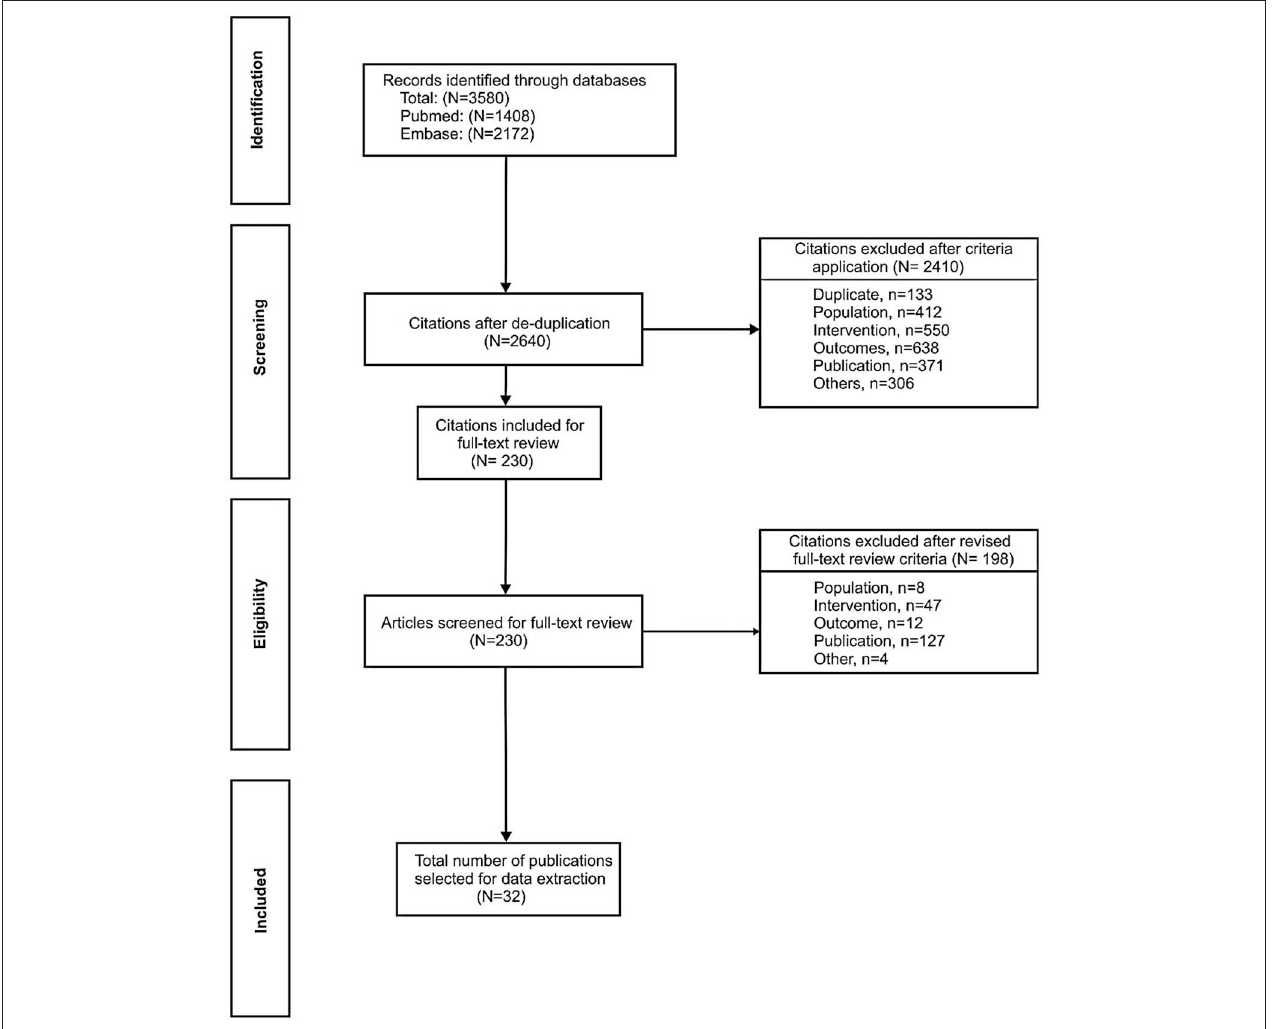
FIGURE 1 | PRISMA flow diagram of included studies. To supplement the 32 publications identified through the systematic process, data from three additional publications were also reviewed as they were considered to provide relevant information; two had been excluded during the systematic search on the basis of their publication type (editorial/letter) (19, 20) and one was published subsequently to the search end date